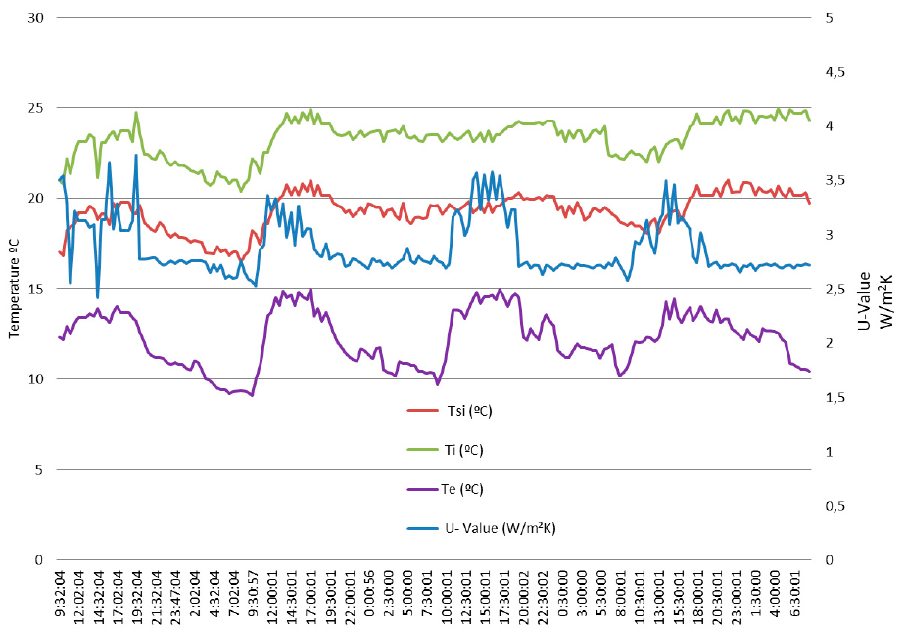
Figure 10. Measures taken with the developed U-Value metre before the energy retrofitting.